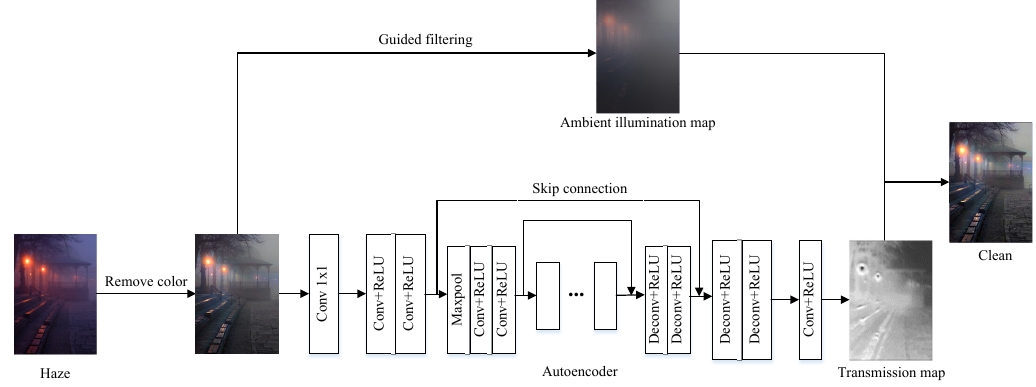
Figure 2. The proposed nighttime dehazing